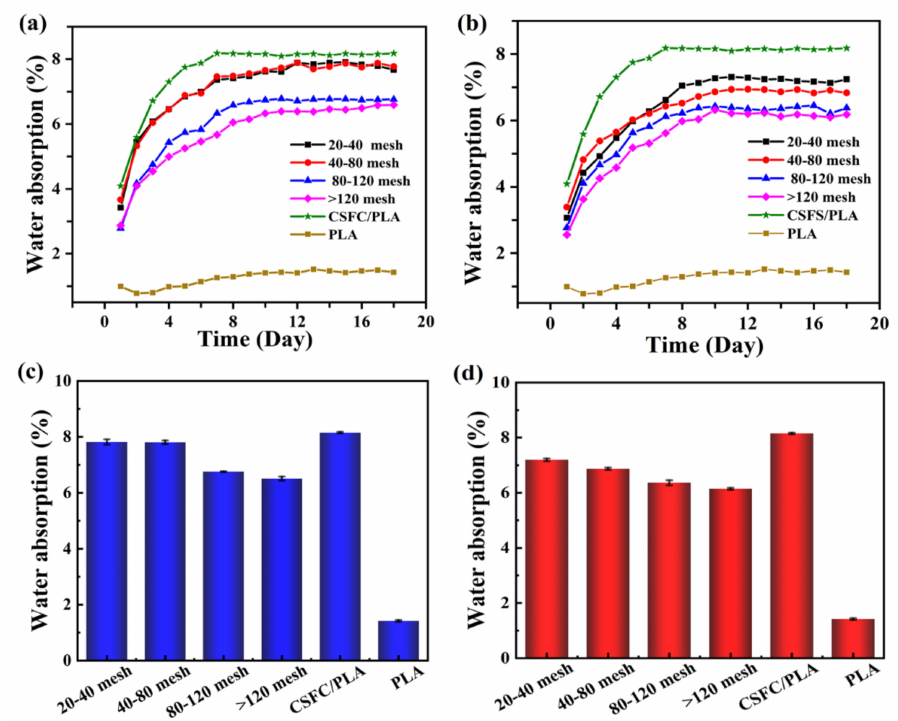
Figure 5. Changes in water absorption curves of CSFS/CSFC/PLA composites ( a ) and CSFS/PLA composites ( b ) within 18 days with different particle sizes; saturated water absorption of CSFS/CSFC/PLA composites ( c ) and CSFS/PLA composites ( d ) with different particle